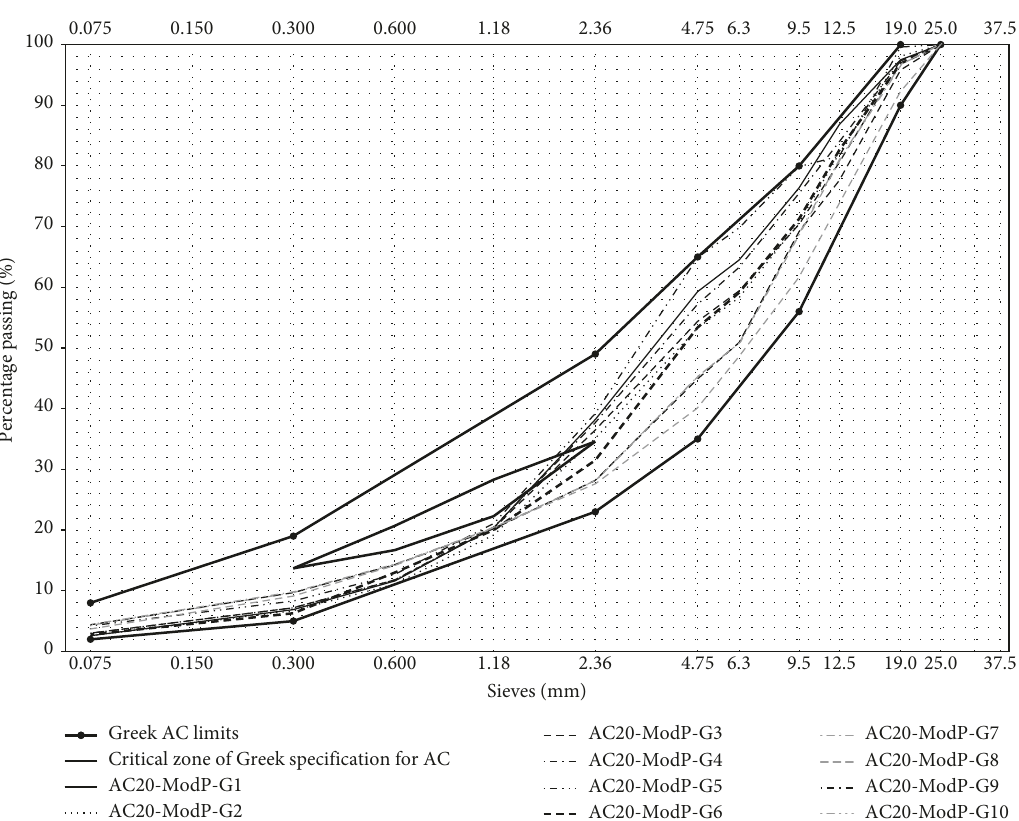
Figure 2: Gradation curves of AC20-ModP (gradations of different production